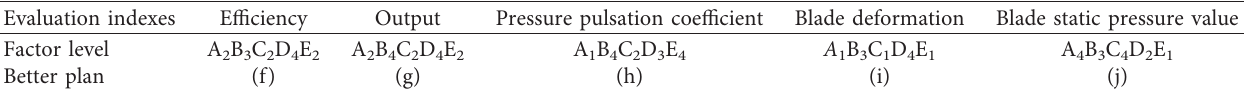
Figure 11: The relationship between various factor levels and indicators: (a) efficiency index; (b) output index; (c) pressure coefficient index; (d) blade deformation index; (e) blade static stress index. Table 8: The better solution of range